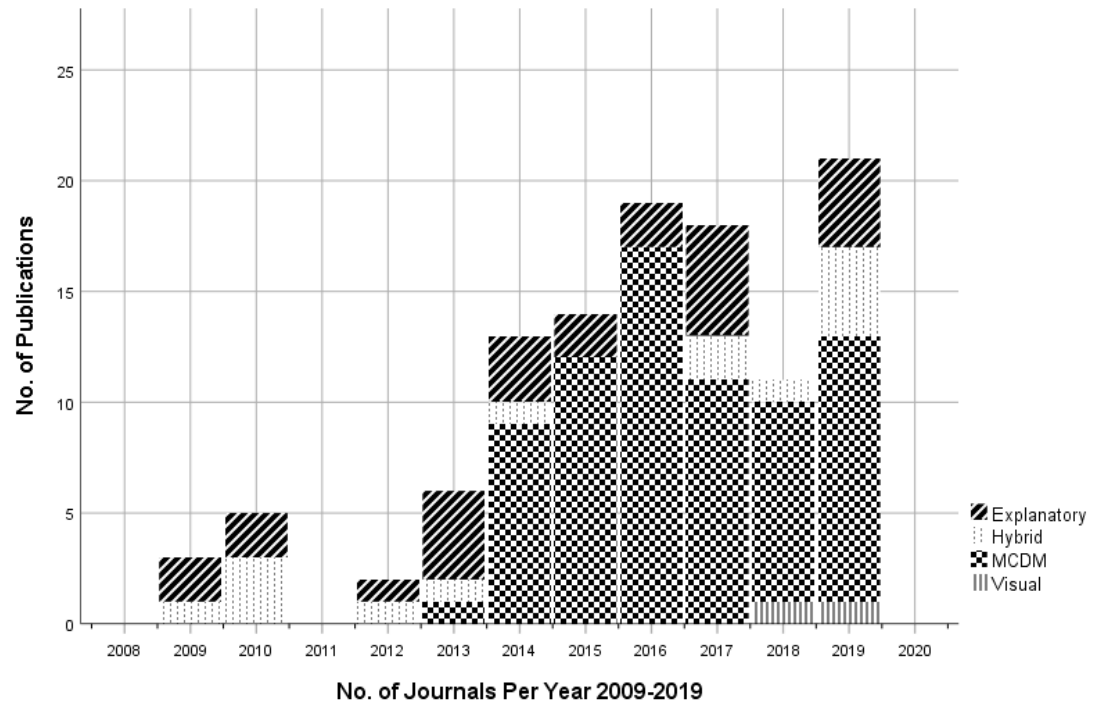
Figure 2. Research in decision making over the study period. Table 2. Summary of major journal